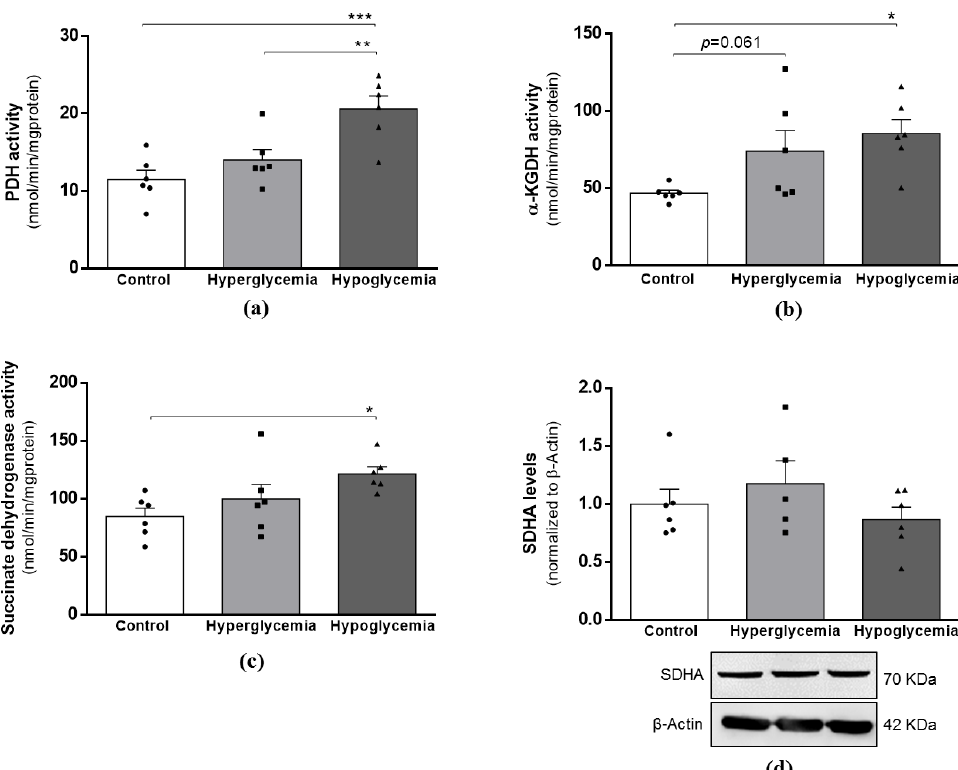
Figure 3. Effects of long-term hyperglycemia and insulin-induced recurrent hypoglycemia on the activity and expression of key Krebs cycle enzymes. ( a ) PDH activity, ( b ) α -KGDH activity and ( c ) SDH activity in brain cortical mitochondria from control, hyperglycemic and insulin-induced recurrent hypoglycemic rats. ( d ) SDH expression levels in brain cortical tissue extracts from control, hyperglycemic and insulin-induced recurrent hypoglycemic rats. Data represent the mean ± SEM of the quantification of brain cortical samples from 5–6 animals under each condition studied. When applied, representative immunoblots are shown below the graph, and β -Actin represents the loading control (for uncropped images of the Western blot, please see Supplementary Data). **** p < 0.001, ** p < 0.01 and * p < 0.05 were considered statistically significant differences. PDH—Pyruvate dehydrogenase; α -KGDH—Alpha-ketoglutarate dehydrogenase; SDH—Succinate